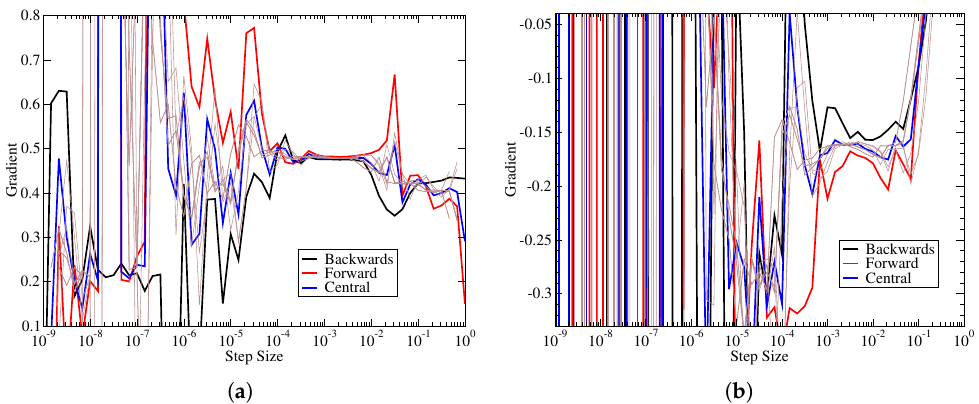
Figure 5. Examples of various finite difference gradients at different levels of quality. ( a ) Quality measure 1 × 10 − 5 straight blade gradients. ( b ) Quality measure 1 × 10 − 3 straight blade